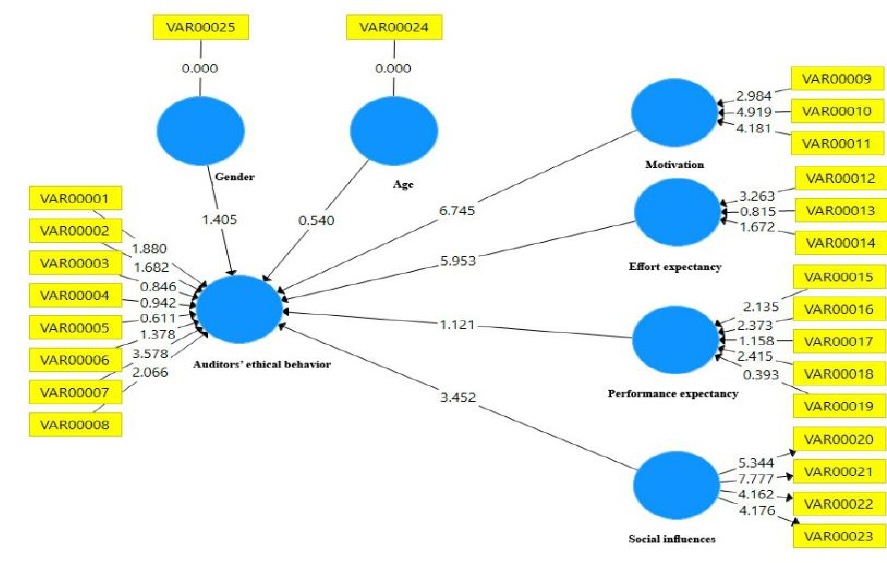
Fig. 5. T-value statistics of the research sub-hypotheses with the bootstrap